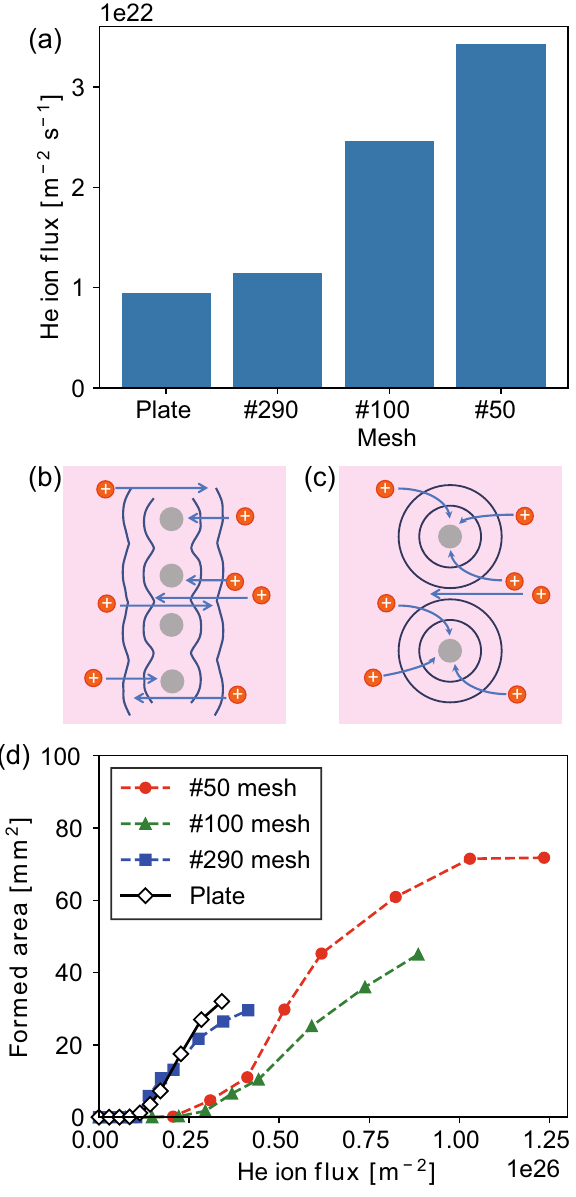
Figure 7. ( a ) Ion flux on the W-plate and W-mesh, schematics of trajectories of ions on the mesh ( b ) with the mesh opening less than the sheath thickness and ( c ) larger than the sheath thickness, and ( d ) LFN formed area as a function of the He ion